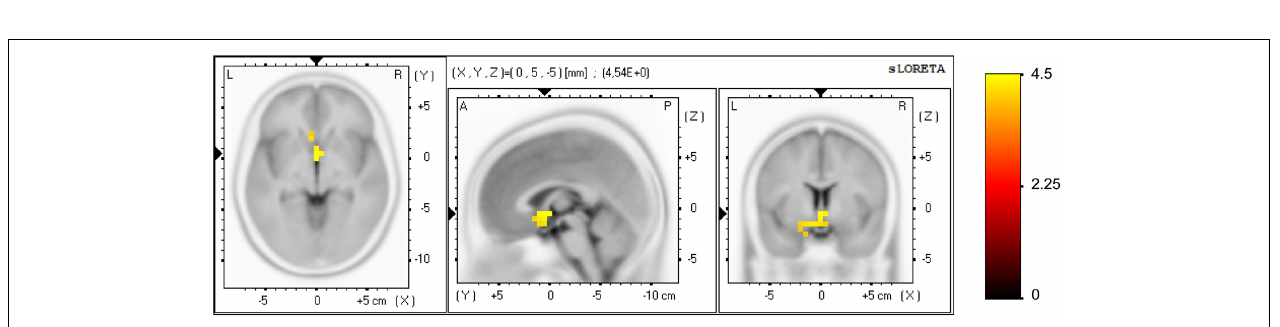
range, whereas Y axis shows the sensor locations. Topoplots are displayed in the frequency bands with power changes above the q threshold (in significant clusters), and the involved sensors are marked with a cross. Color scale represent t -values, indicating a power increase after the NF training.